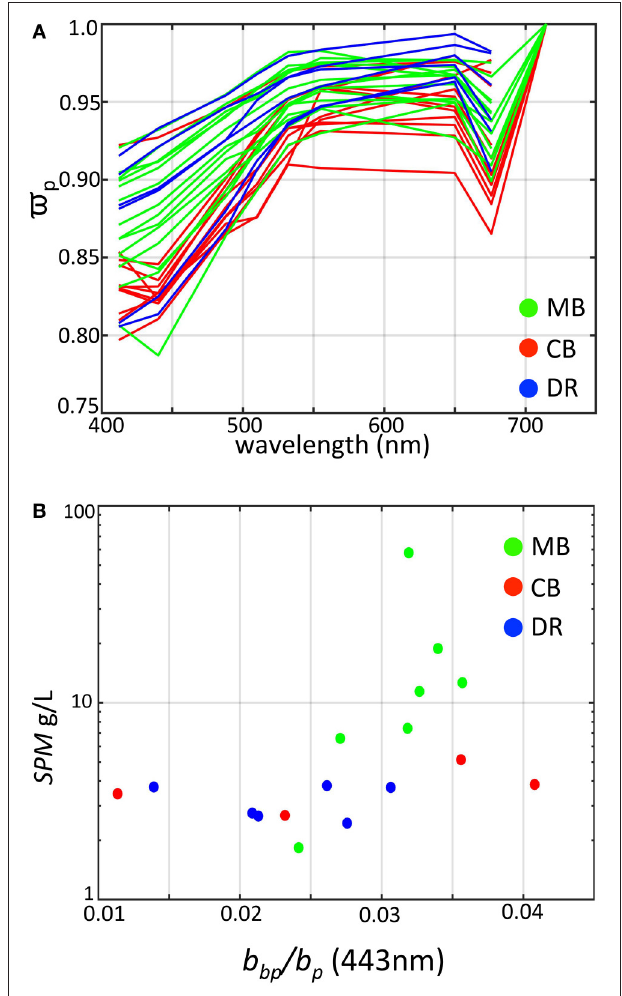
FIGURE 7 | Derived scattering properties of western Lake Erie as determined from WET Labs bb9 measurements colored by region. (A) Single scatter albedo colored by region; (B) SPM vs. particle backscatter ratio at 443